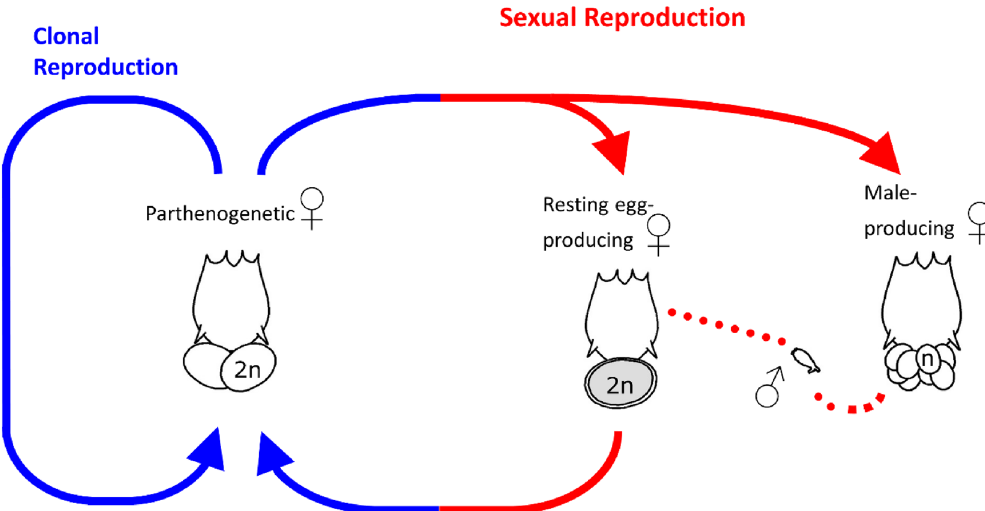
Figure 1. Schematics of rotifer life cycle. Monogonont rotifers are cyclical parthenogens, capable of both ameiotic parthenogenesis and sexual reproduction. The production of sexual females is triggered by quorum sensing chemicals, released by the animals themselves at high population density. In contrast to parthenogenetic females, sexual females produce oocytes by meiosis, and give rise to either haploid males or diploid resting eggs, depending on whether they get fertilized by a male 24